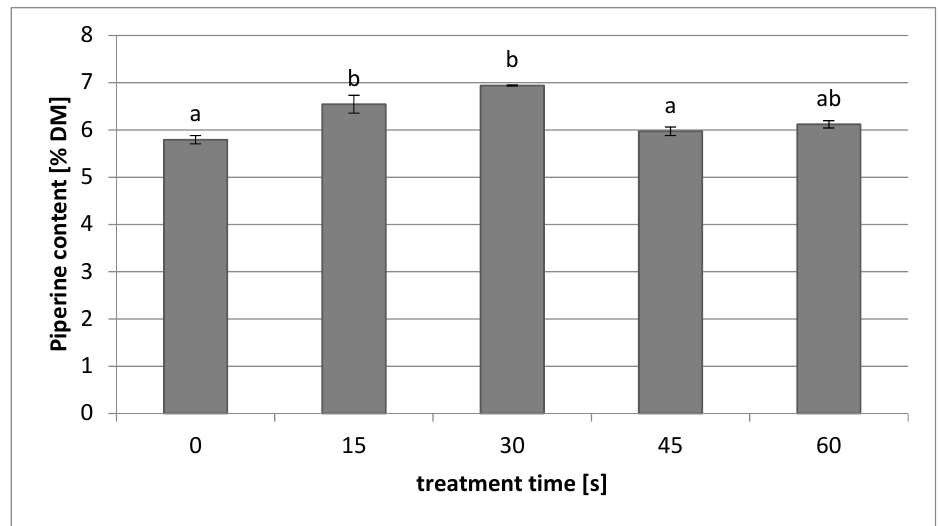
Figure 9. Piperine content in black pepper seeds untreated and treated by microwave plasma for different times. Different letters (a, b, c…) indicate statistically significant difference between samples ( α = 0.05).